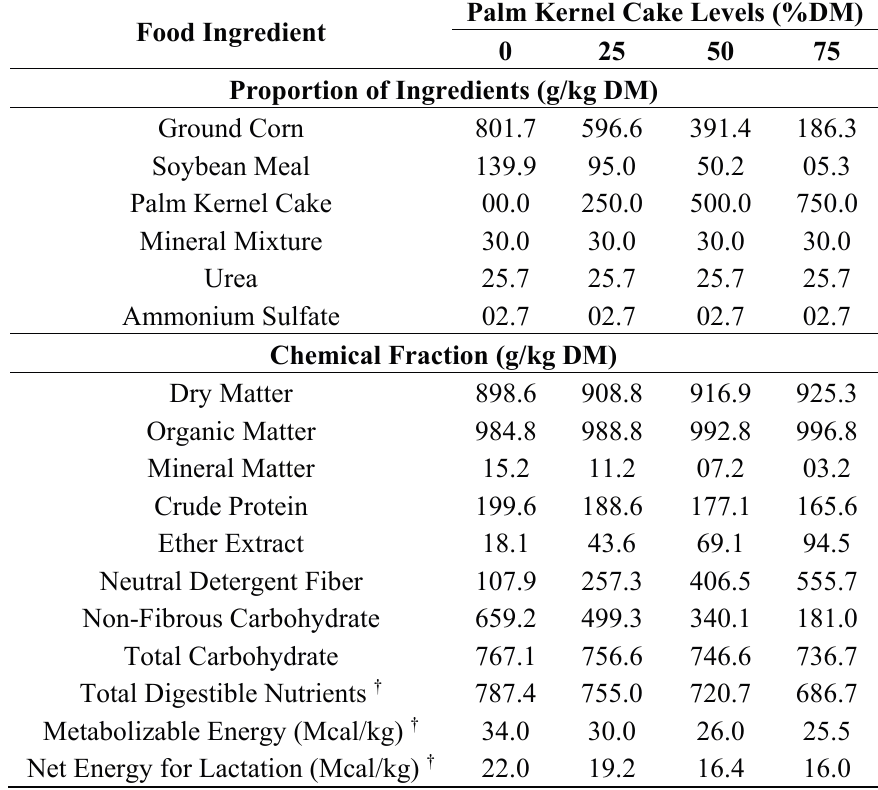
Table 7. Proportion of ingredients and chemical composition of the concentrates used to supplement lactating cows when calculated as percentages on a dry matter